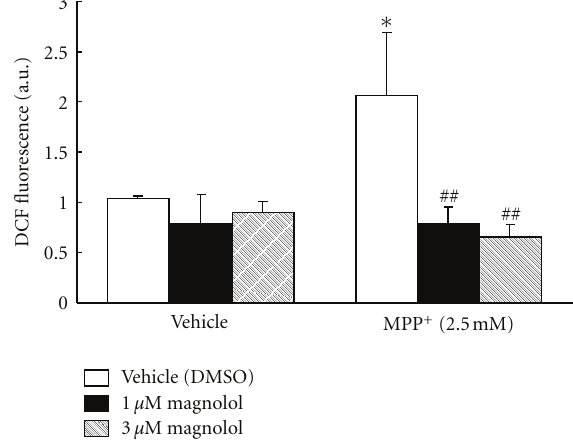
Figure 6: E ff ect of magnolol on ROS production in MPP + -treated human neuroblastoma SH-SY5Y cells. Cells were incubated with H 2 DCF-DA for 30 min at 37 ◦ C. And then, 2.5 mM MPP + in the presence or absence of magnolol (1 or 3 μ M) were exposed for 24h. ROS production was assessed by DCF fluorescence. These are representative results from two independent experiments. Results are means ± SD ( n = 3). Statistical comparisons were carried out by one-way ANOVA followed by Dunnett’s test. ∗ P < 0 . 05 versus vehicle (DMSO), ## P < 0 . 01 versus MPP + + vehicle